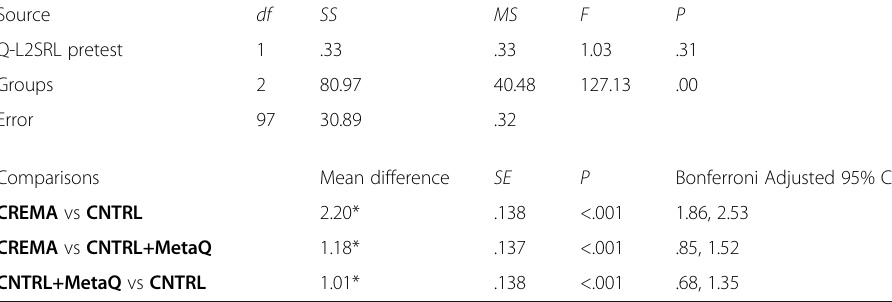
Table 5 ANCOVA results, multiple comparisons, and mean differences in Q-L2SRL posttest for Q- L2SRL pretest Source df SS Q-L2SRL pretest